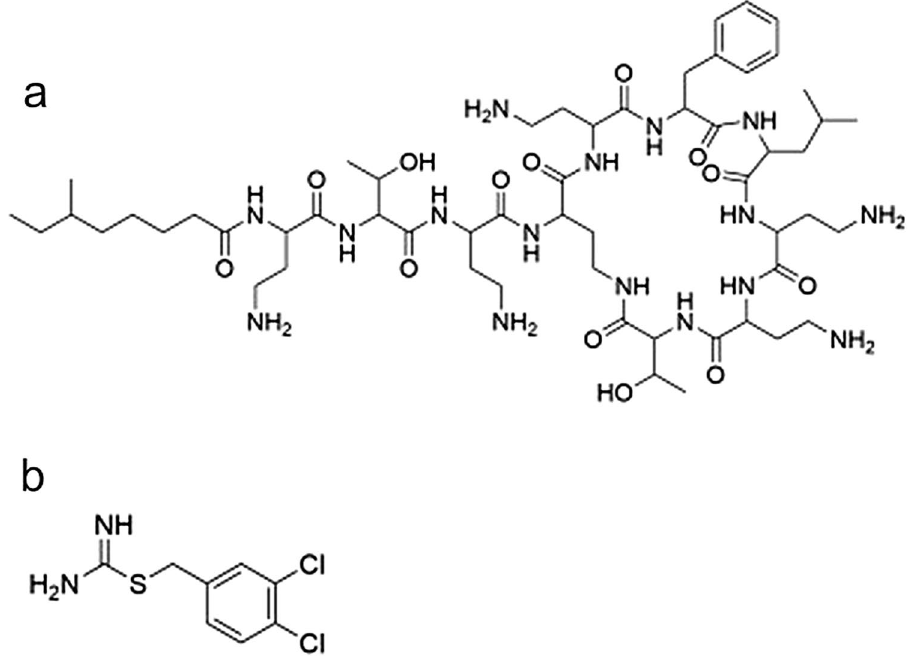
Figure 5. Chemical structures of the antibacterial molecules polymyxin B and A22. ( a ) The antibiotic polymyxin B and ( b ) the inhibitor